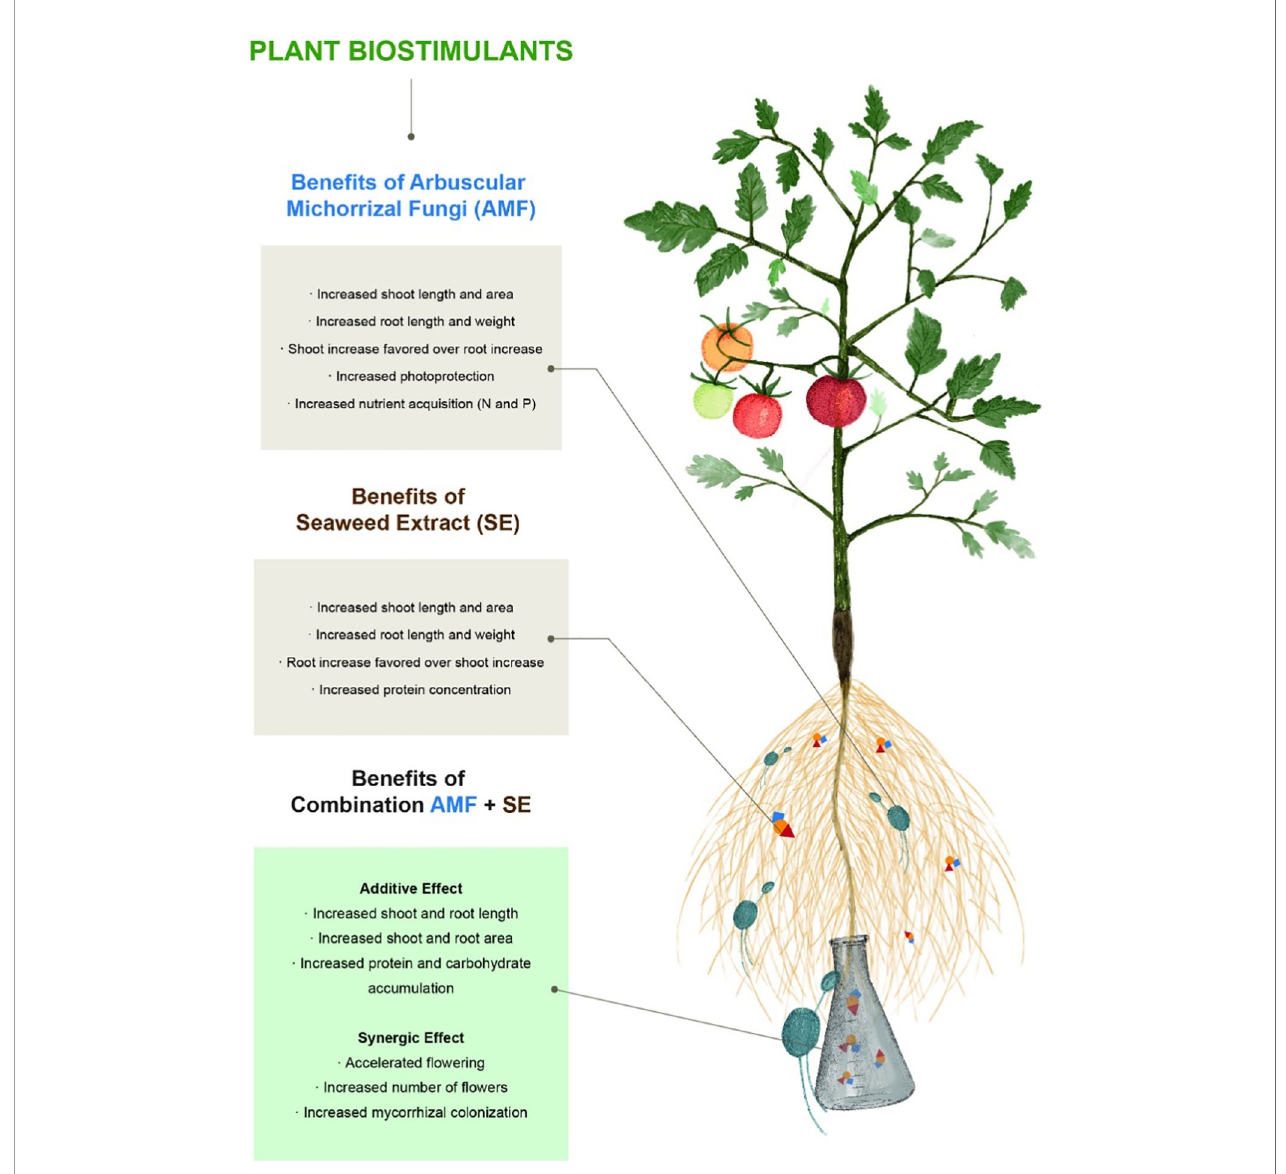
FIGURE 5 | Plant biostimulants contributions of arbuscular mycorrhizal fungi (AMF) and seaweed extract (SE), both alone and in combination on tomato plants ( Solanum lycopersicum L. cv. “ Rio Fuego ”